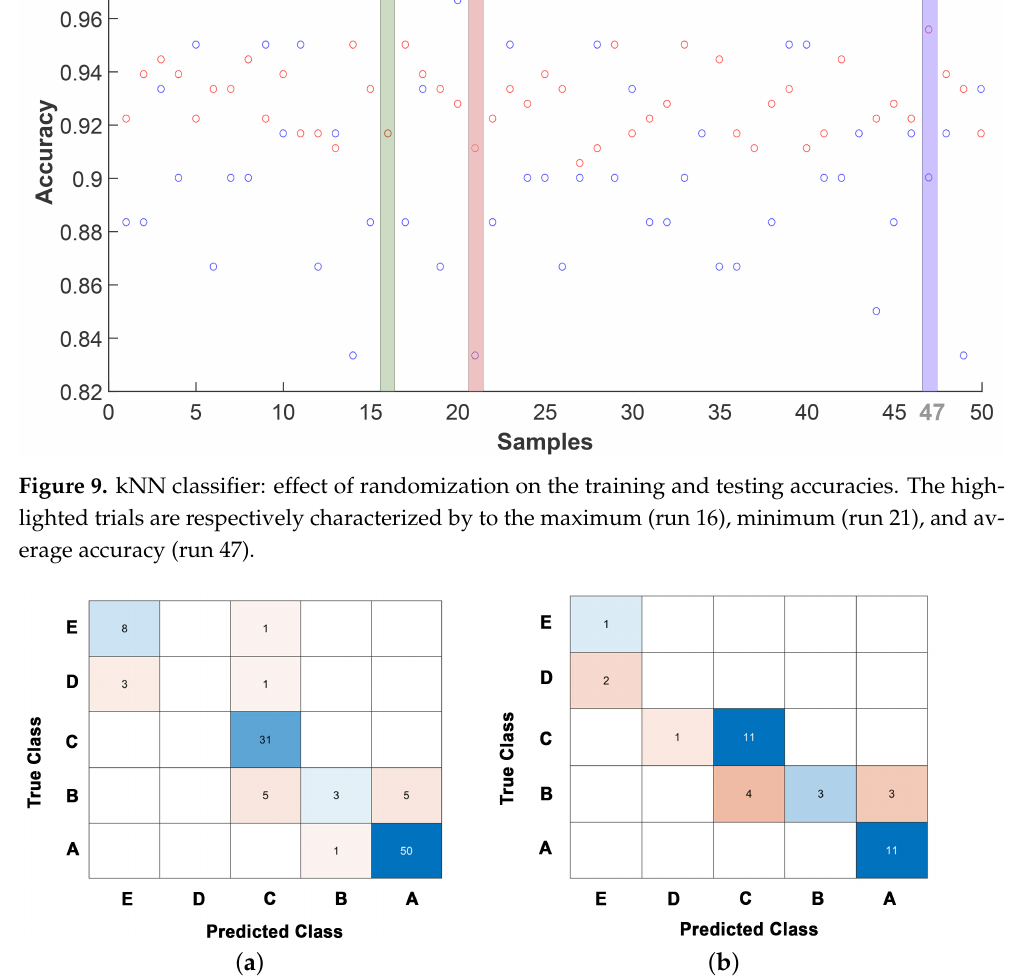
Figure 10. kNN classifier (run 21): confusion matrices relevant to the ( a ) training and ( b ) test- ing